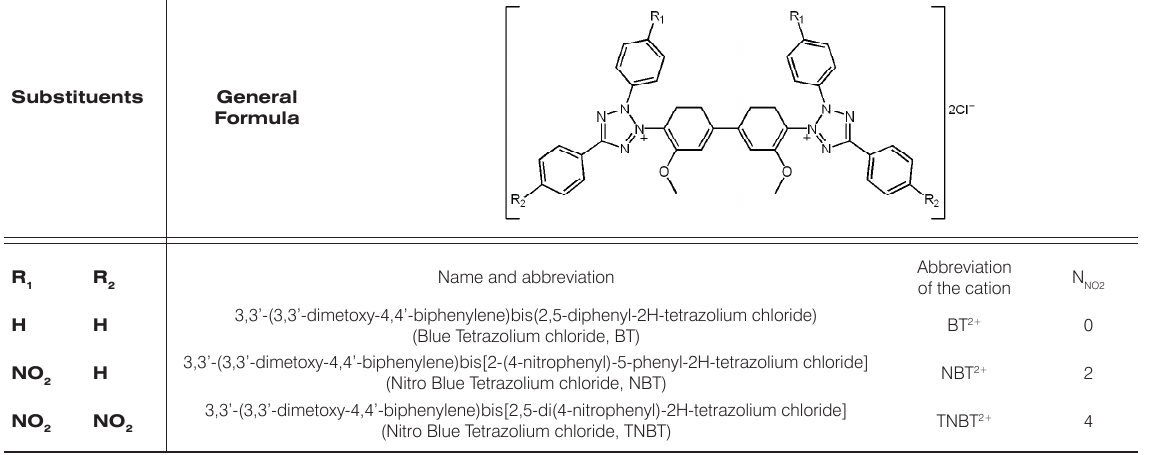
Substituents General